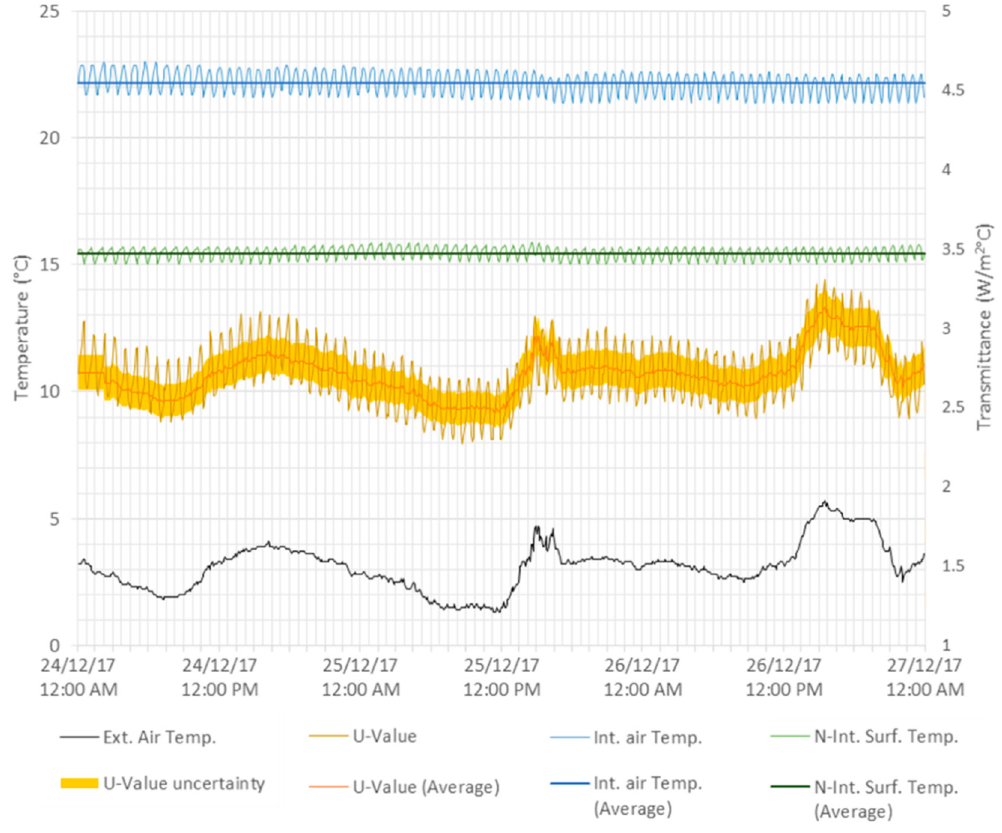
Figure 4. Interior air and surface temperatures, exterior air temperature and U-value calculated of the Earthbag wall. Data taken from experimental monitoring.